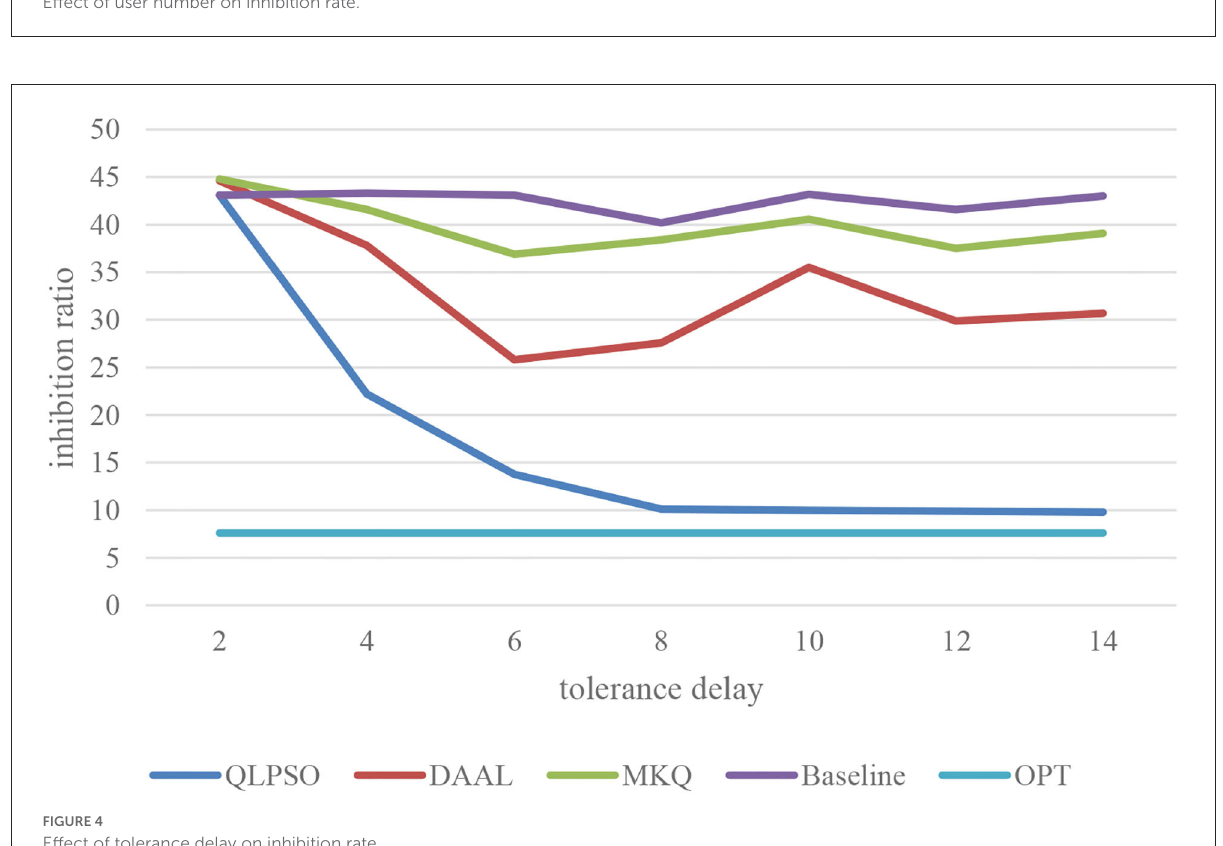
FIGURE3 Effect of user number on inhibition rate.